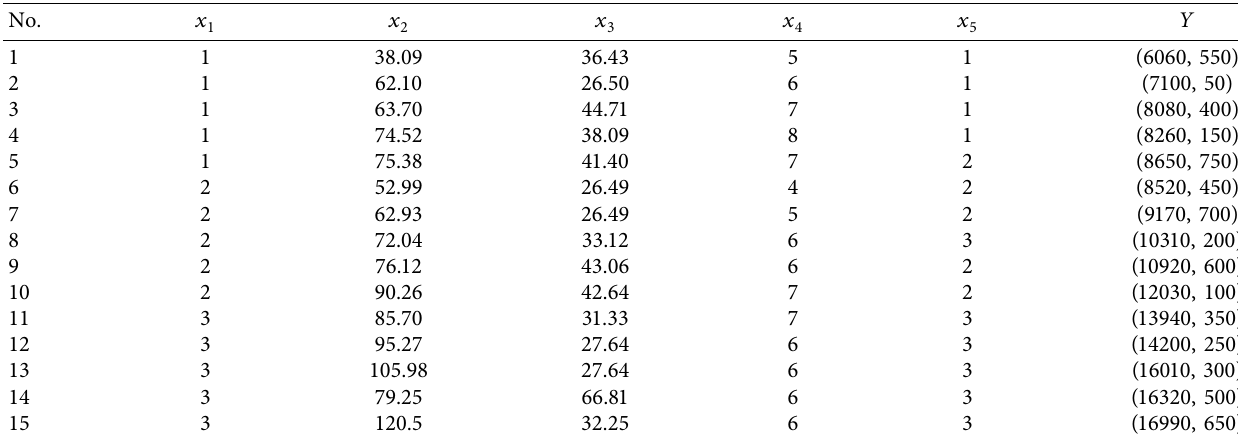
Figure 9: Fuzzy bubble plots in Example 1. (a) Proposed fuzzy bridge regression model with c � 1, (b) proposed fuzzy bridge regression model with c � 2, (c) proposed fuzzy bridge regression model with c � 3, and (d) proposed fuzzy bridge regression model with c � 3 . 7. Table 4: Observed and estimated data in Example